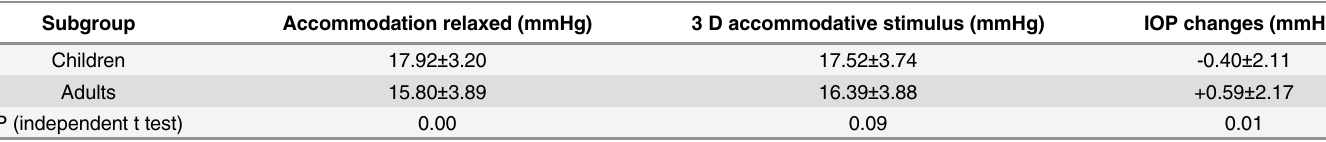
Table 4. The IOP of children and adults subgroups before and after accommodation.